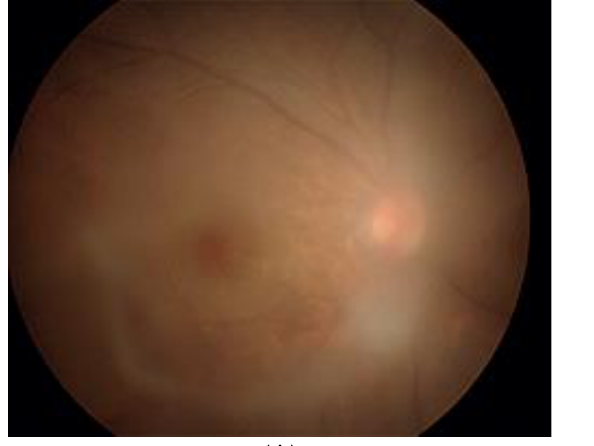
Figure 2. HU occurred after methimazole treatment following the onset of Graves’ disease. ( A ) Vit- reous opacity is seen in the right eye. ( B ) Retinal vasculitis can be seen by fluorescein angiography. (Reproduced with permission from Kamoi et al., Lancet. 2022 [43]).